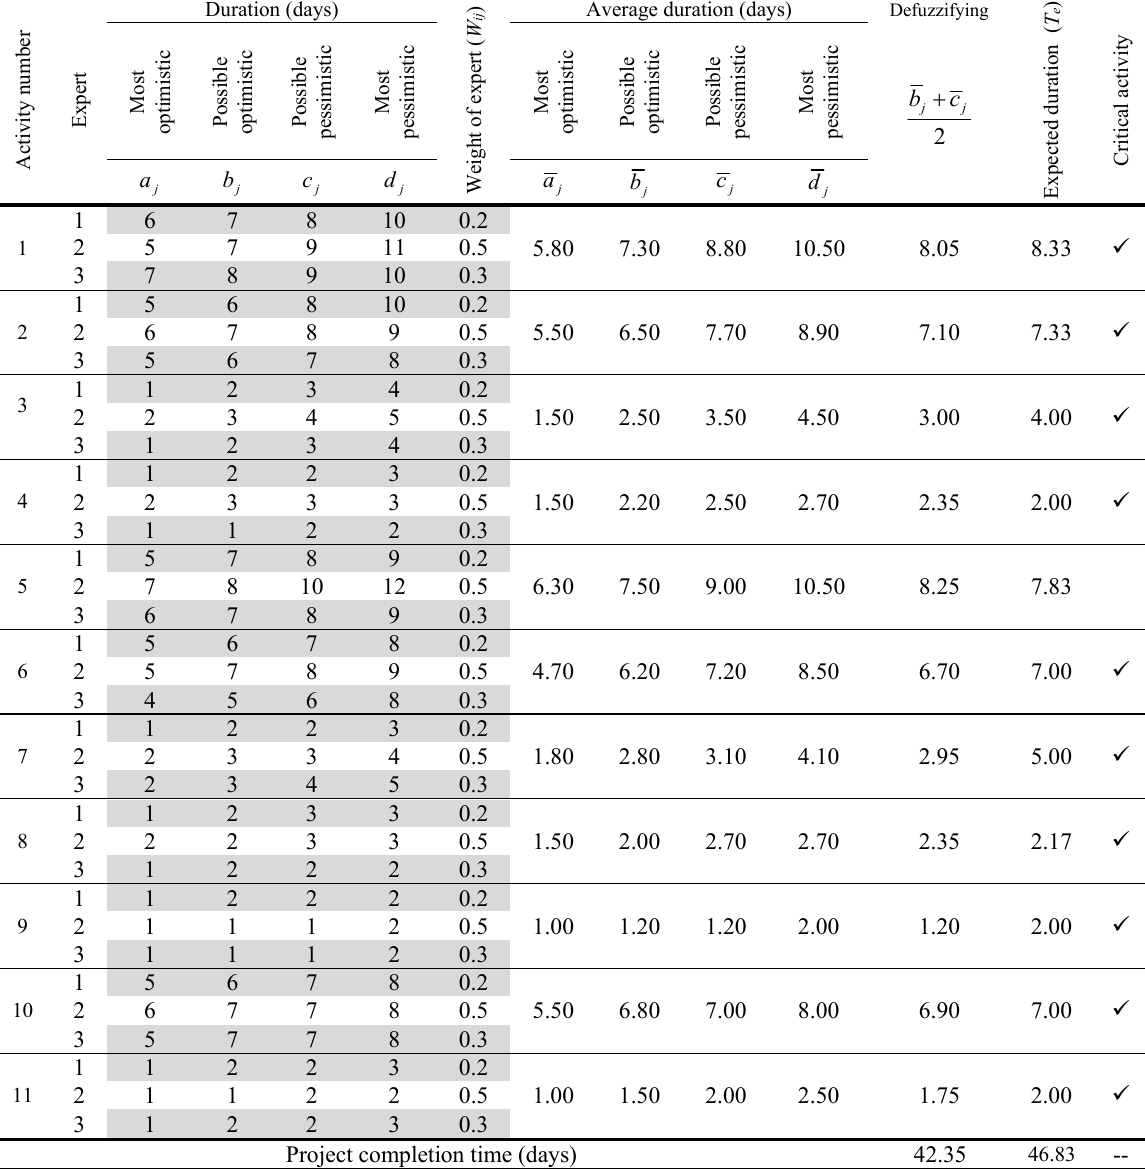
Calculation of activities duration using proposed